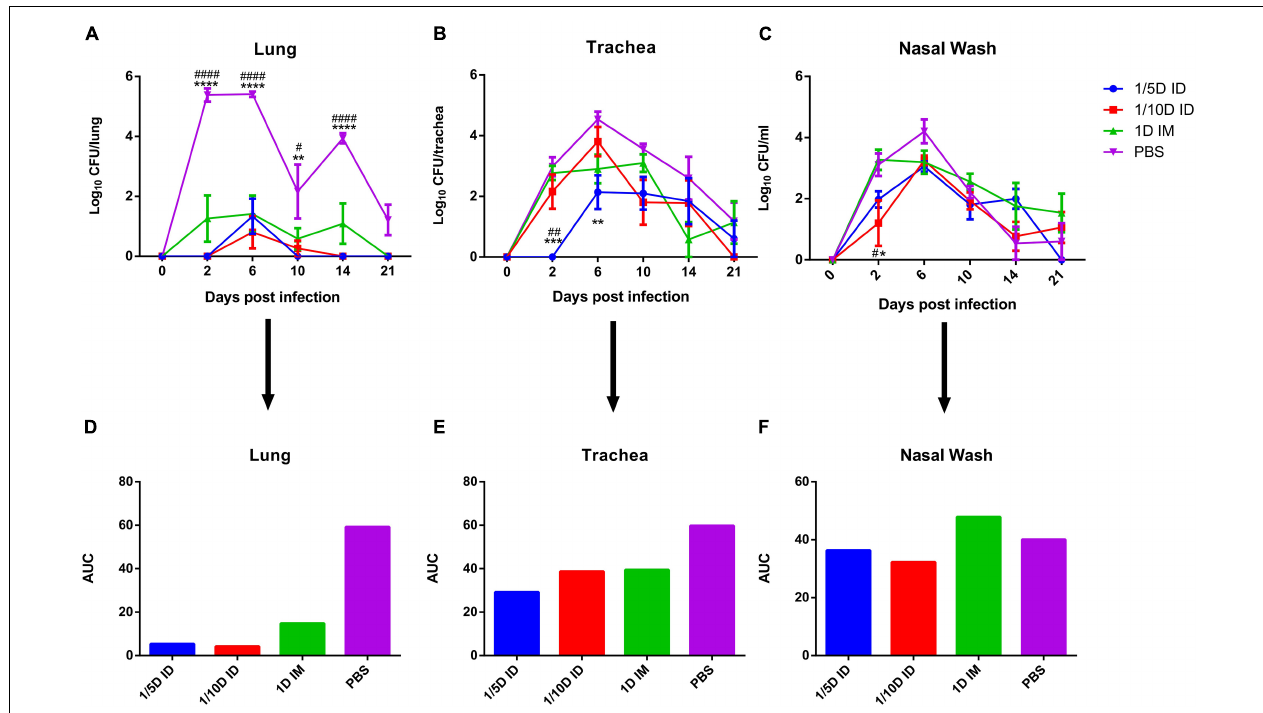
FIGURE 5 | Intradermal immunization induced more effective protection against B. pertussis infection. Protection of rat against B. pertussis infection induced with the 1/5 or 1/10 human dose ID immunization compared with 1HD dose IM immunization or PBS. Rats were challenged 4 weeks after the third immunization by aerosol with B. pertussis (1 × 10 11 CFU/ml) over 30 min. Results were shown as the number of bacteria recovered from the rat lungs at different time points, expressed as the log10 of the means ± SEM ( n = 4 rats per group per time-point) of the CFUs in (A) lung, data was analyzed using a two-way ANOVA model with Tukey’s multiple comparisons test. * P < 0.05, ** P < 0.01, **** P < 0.0001 vs 1/5D or 1/10D ID and # P < 0.05, #### P < 0.0001 vs 1D IM. The CFUs in (B) trachea and (C) nasal wash was shown in figure, expressed as the log10 of the means ± SEM ( n = 4 rats per group per time-point). * P < 0.05, ** P < 0.01, *** P < 0.001 vs PBS and # P < 0.05, ## P < 0.01 vs 1D IM group. (D–F) show the areas under the bacterial clearance curves corresponding to the curves in panels (A–C)